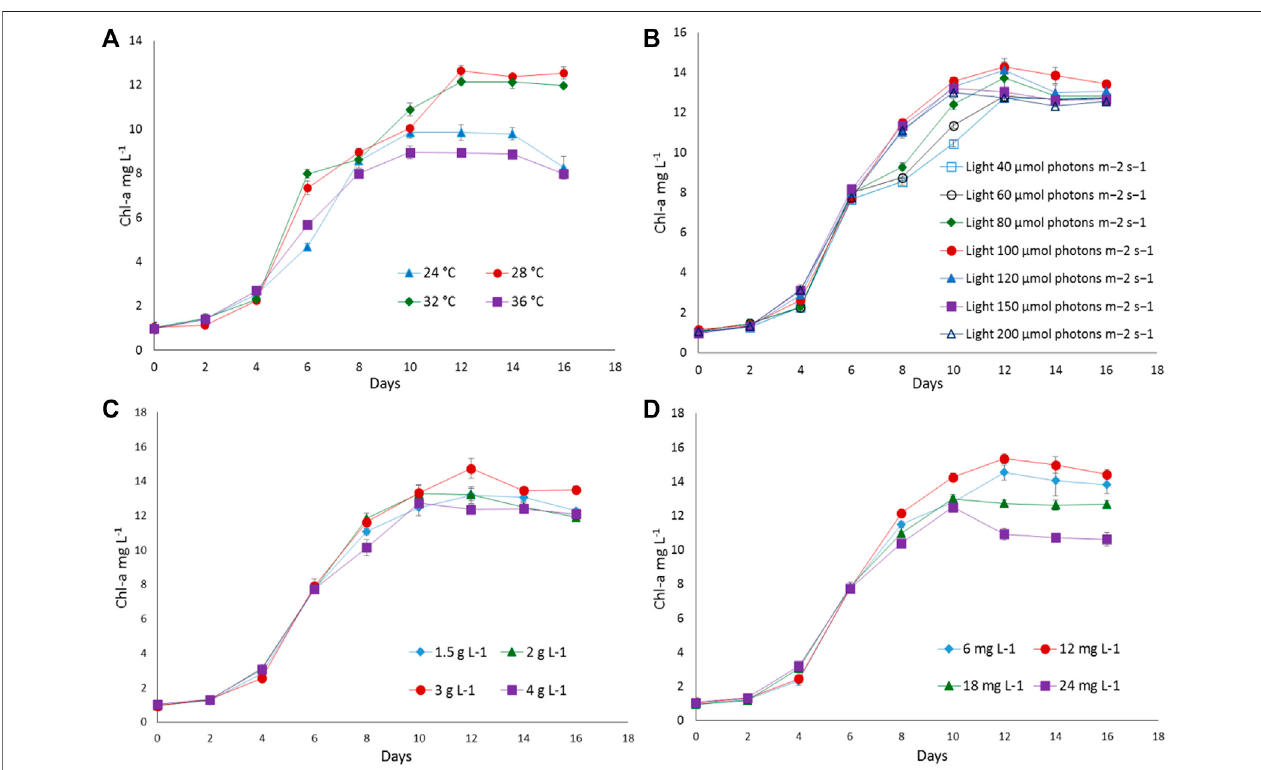
FIGURE2| Thegrowthresponseof Euryhalinema sp.todifferent (A) temperatures, (B) lightintensities, (C) sodiumnitrateconcentrations,and (D) ferricammonium citrate concentrations. Error bars represent ± SD (n (cid:2) 3).